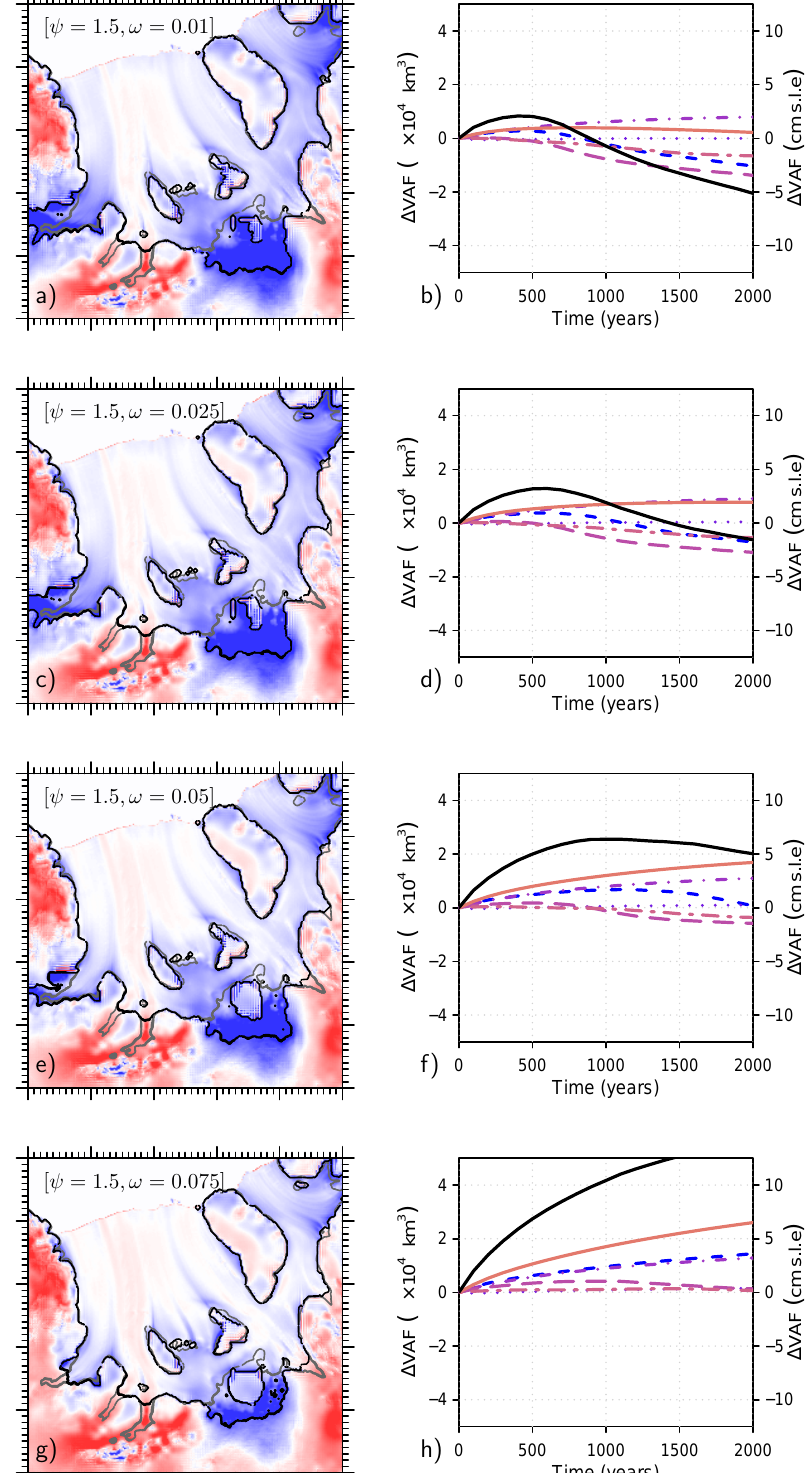
Figure 8. Ice thickness changes and grounding line locations along with time series plots of cumulative volume above flotation change by basin. In all plots the basal mass balance multiplier ψ = 1 . 5, but ω varies: ( a and b ) ω = 0 . 01mw.e.; ( c and d ) ω = 0 . 025mw.e.; ( e and f ) ω = 0 . 05mw.e and ( g and h ) ω =